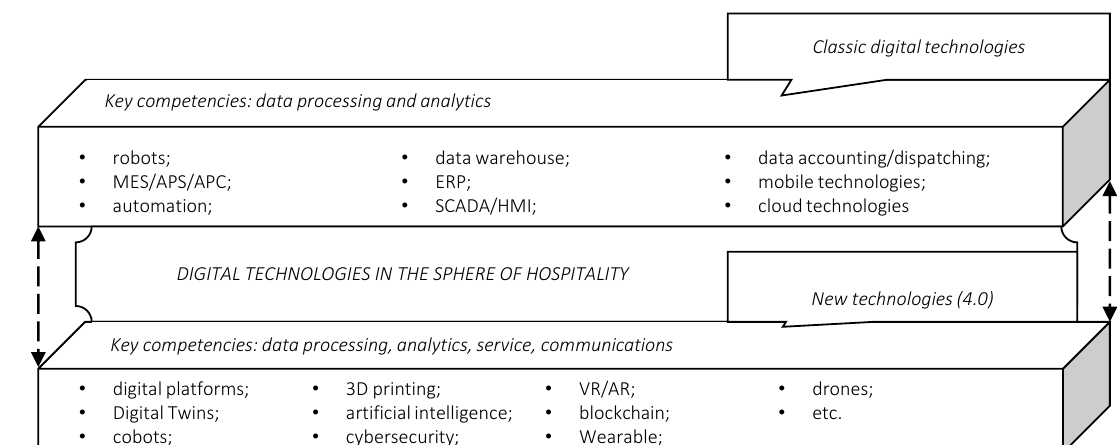
Figure 1. Key digital technologies in the hospitality industry